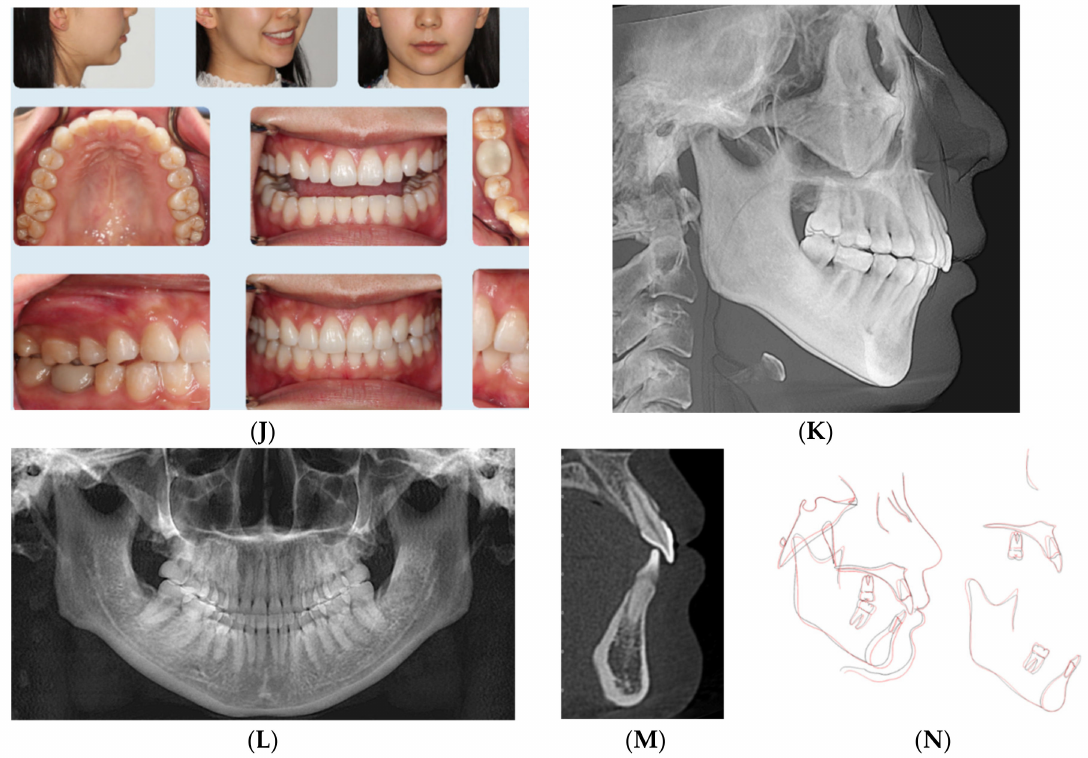
Figure 1. ( A ) Initial photographs showing the patient’s convex profile with recessive chin and anterior crowding. ( B ) Initial digital models showing left side Class II buccal occlusion with increased overjet 5 mm. ( C ) CBCT-driven cephalometric radiograph showing convex profile and recessive chin. ( D ) CBCT panoramic radiograph showing the patient is missing all third molars; no other noticeable intraoral bony lesion could be detected. ( E ) CBCT = driven sagittal screen of lower incisor showing its severe proclination with minimum bone appearing on most of the labial surface of the root. ( F ) A photo of the Jaw Bra (Chanhassen, MN USA). ( G ) Digital treatment plan (ClinCheck) showing posterior teeth distalization, mesio-bucaal rotation and intrusion to help forward rotation of the mandible to full Class I. ( H ) Upper arch digital treatment plan (ClinCheck) showing expansion (blue—initial teeth position, white—final teeth position). ( I ) Lower arch digital treatment plan (ClinCheck) showing expansion (blue—initial teeth position, white—final teeth position) to allow lower incisor intrusion and leveling / alignment of lower incisor crowding. ( J ) Final photos showing improved patient’s profile and chin projection as well as aligned upper and lower incisors and Class I buccal occlusion both sides. ( K ) CBCT-driven final cephalometric radiograph showing improved profile and chin projection ( L ). Final CBCT-driven panoramic radiograph. ( M ) Final CBCT-driven sagittal screen radiograph of upper and lower incisors showing improved bone labial to both upper and lower incisors. ( N ) Superimposition of cephalometric tracing of before (black) and after (red) treatment showing improved forward chin projection, palatal root torque of upper incisors, and profile and chin projection and lingual tipping of lower